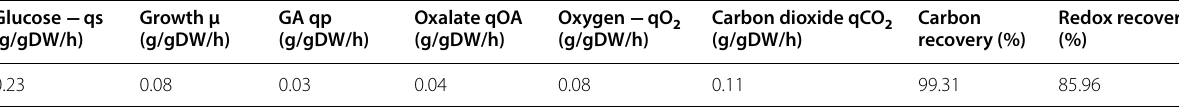
Table 1 Specific rates in steady state Glucose qs −